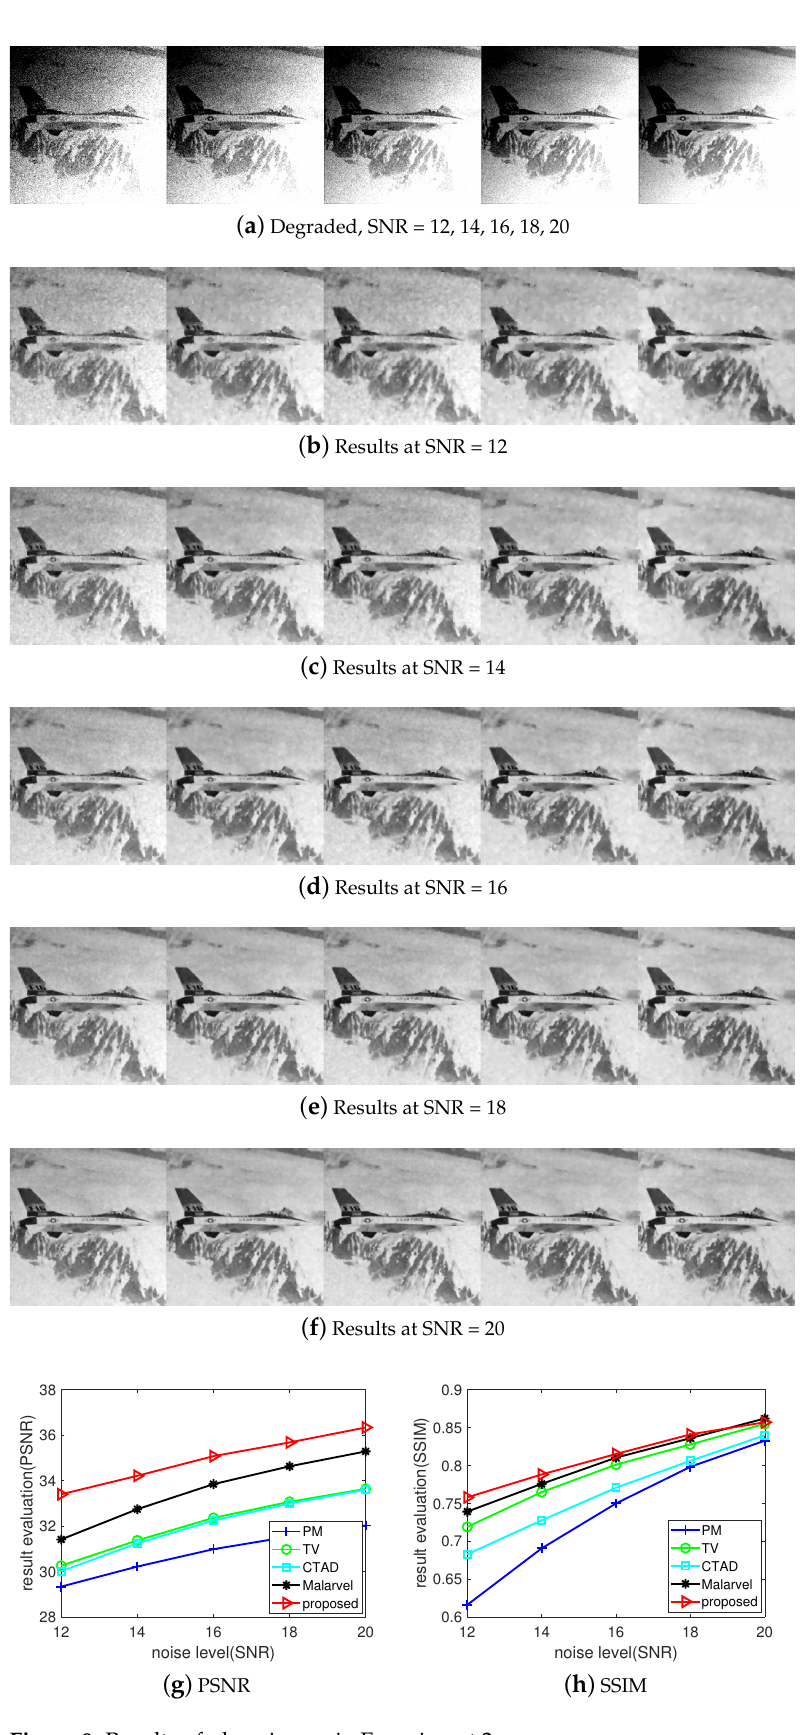
Figure 9. Results of plane image in Experiment